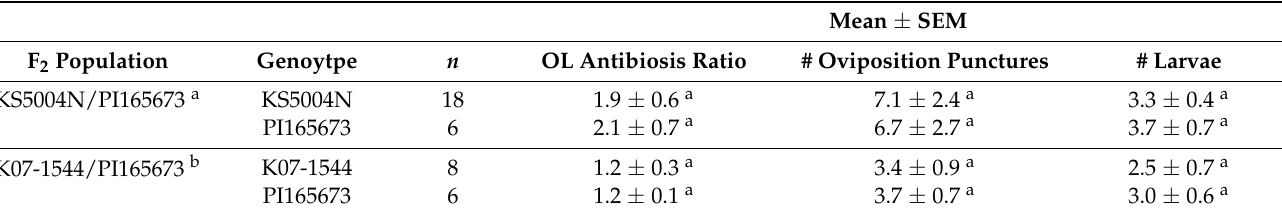
Table 1. Mean ± SEM OL antibiosis ratios, and number of oviposition punctures and number of larvae per plant in F 2 soybean populations KS5004N/PI165673 and K07-1544/PI165673 at 21 d post infestation with Dectes texanus in 2011. Mean ± SEM F 2 Population Genoytpe n OL Antibiosis Ratio # Oviposition Punctures